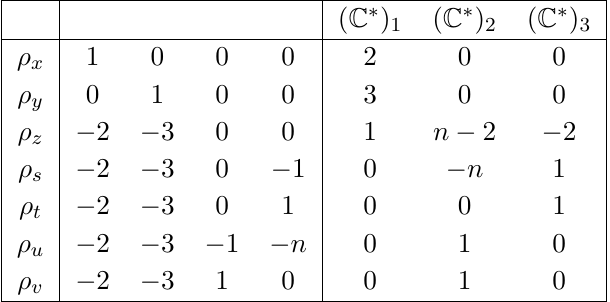
(cid:8) 3 K F ) ! F n n n